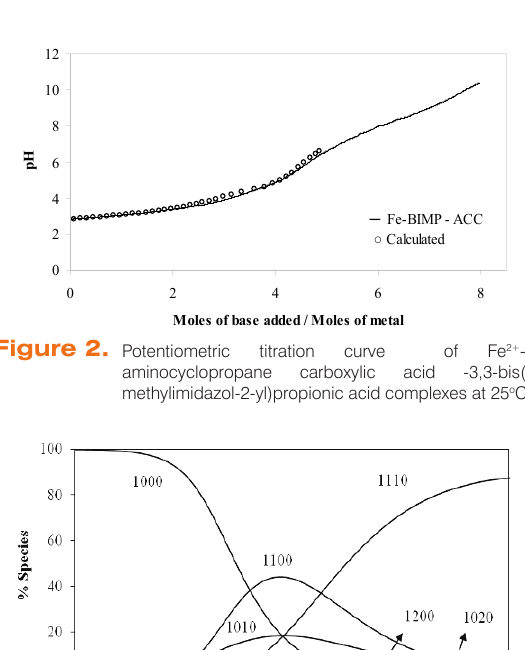
groups as enzyme active sites. The interaction between complex. Therefore, complex formation equilibria of ACC and 3,3-bis(1-methylimidazol-2-yl)propionic acid, especially those of mixed-ligand complexes with Fe 2+ Figure 3. Concentration distribution diagram of Fe 2+ -1- are highly relevant to the biological activity of this class aminocyclopropane carboxylic acid -3,3-bis(1- methylimidazol-2-yl)propionic acid complexes at 25 o of complexes.